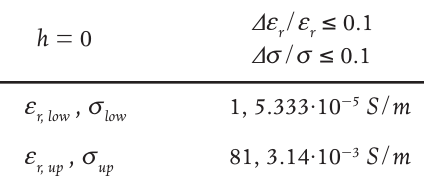
Table 3. Galvanic contact: domains of f and v where Df Dv / v ≤ 0.1, when h = 0.